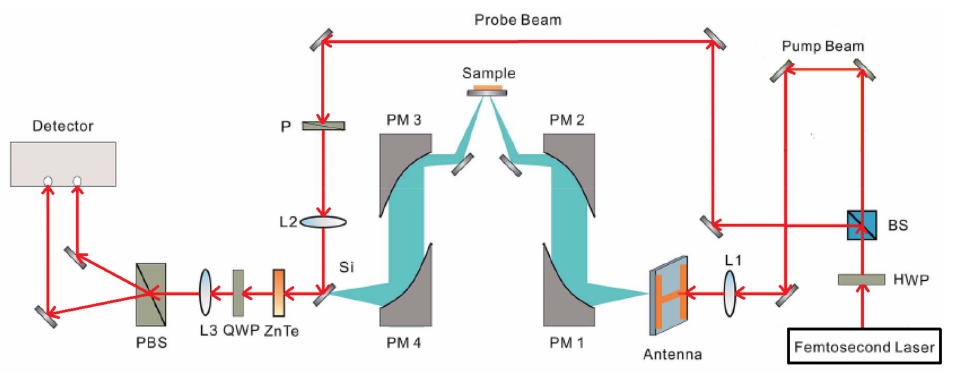
Figure 1. THz-TDS reflective imaging